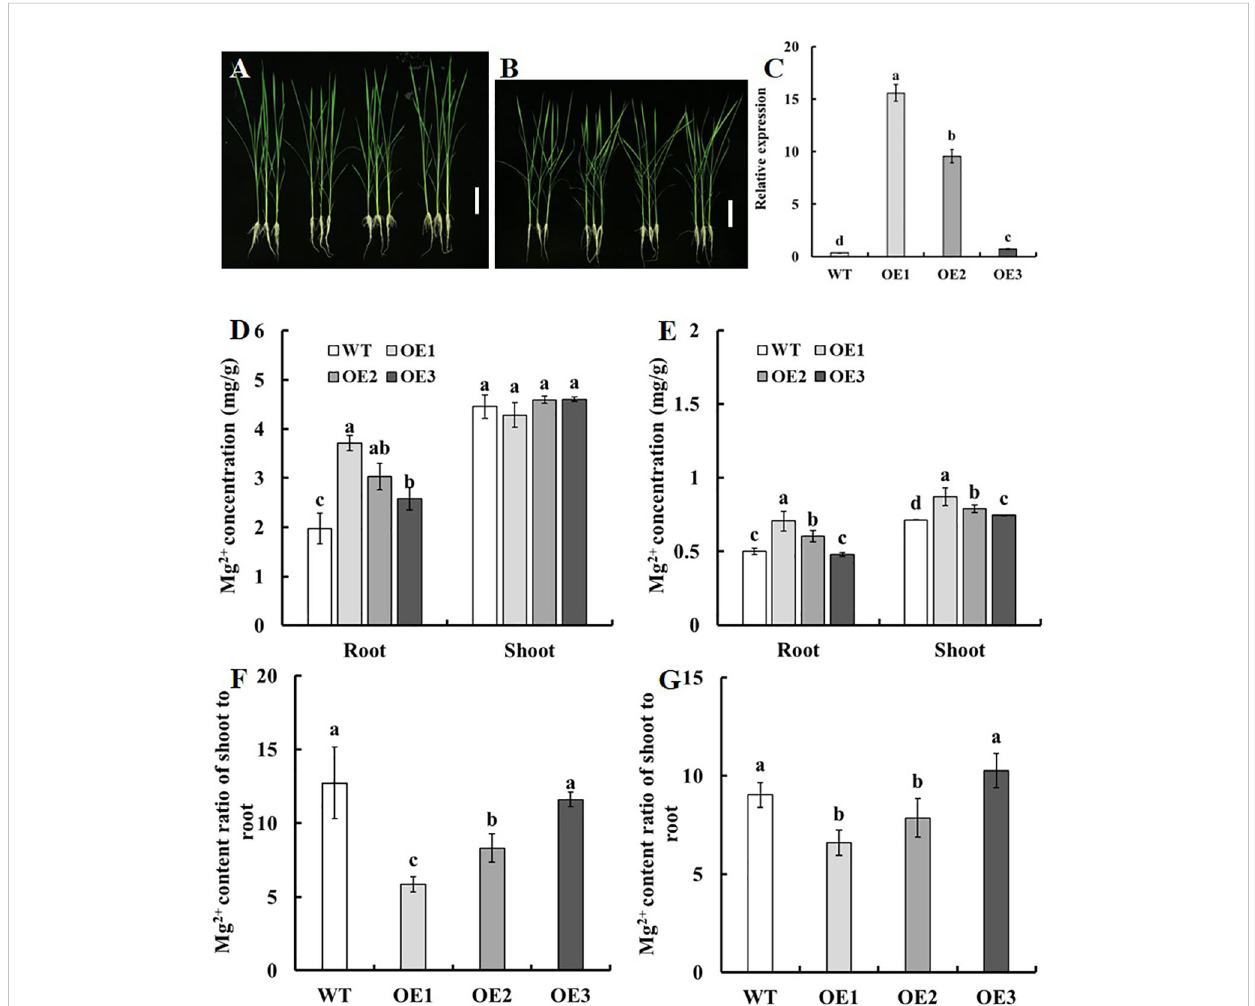
FIGURE 7 Mg 2+ uptake and translocation of the LOC_Os03g04360 overexpression lines. Two-week-old seedlings of the transgenic lines and WT with normal growth were treated with 250 m M Mg 2+ or 10 m M Mg 2+ supply for two weeks. (A, B) Phenotype of the LOC_Os03g04360 overexpression lines grown with (A) 250 m M Mg 2+ and (B) 10 m M Mg 2+ supply. (C) Quantitative real-time PCR analysis of endogenous LOC_Os03g04360 expression in various transgenic lines and WT. RNA was collected from root. The Mg 2+ concentration in roots and shoots in LOC_Os03g04360 overexpression lines and WT under (D) 250 m M Mg 2+ or (E) 10 m M Mg 2+ supply. The shoot-to-root ratio of the Mg 2+ content of seedlings treated with (F) 250 m M Mg 2+ or (G) 10 m M Mg 2+ . Error bars: SE (n = 3 plants). The different letters above the bars indicate a signi fi cant difference between each line ( P <